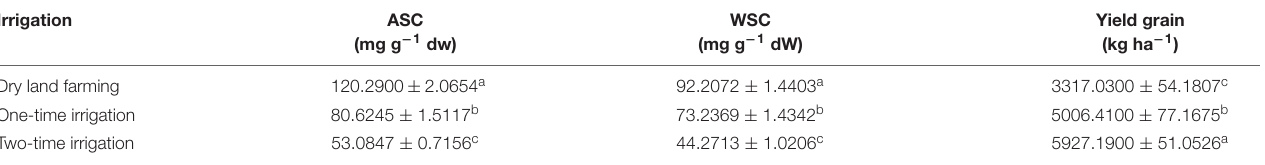
TABLE 9 | Mean comparisons of simple main effects of irrigation levels on some traits in the wheat plant in 2018–2019. Irrigation